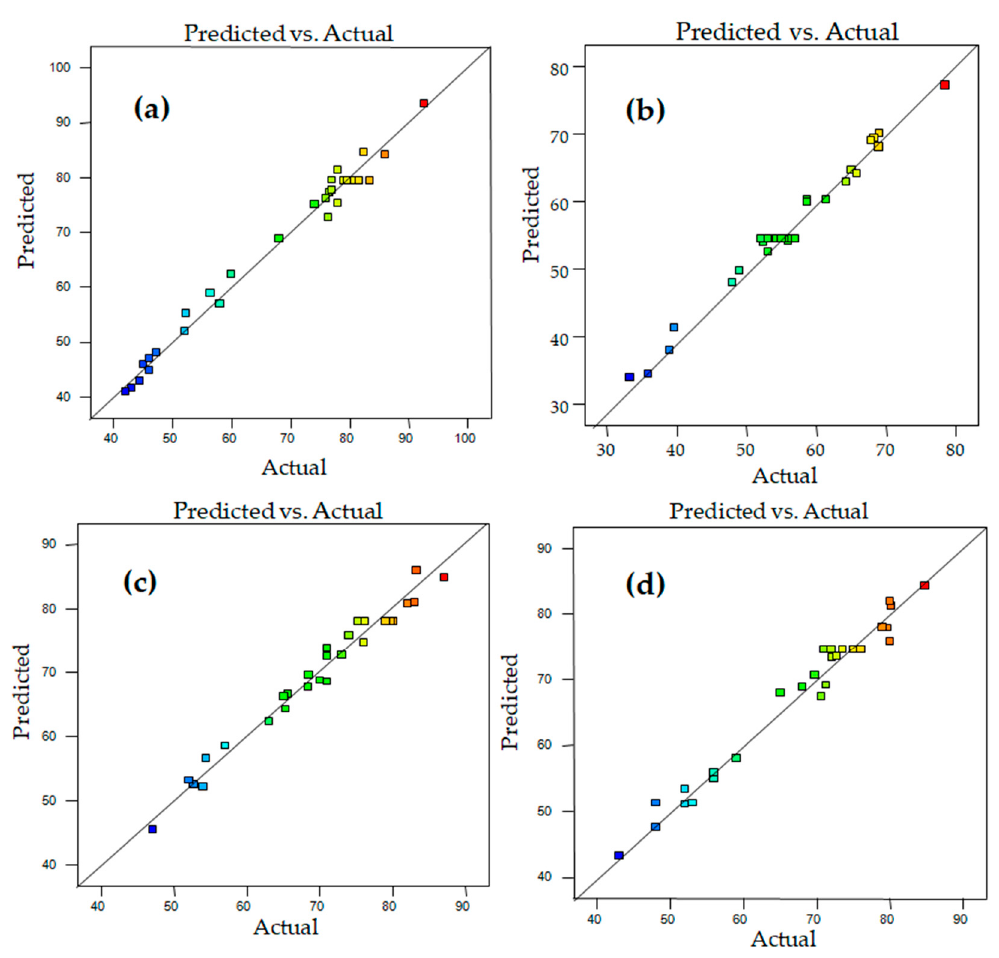
Figure 1. Graphs of predicted vs. actual yield for waste chicken fat oil-based biodiesel by Fe 3 O 4 _PDA_Lipase ( a ), Aspergillus terreus lipase ( b ), Sodium methoxide ( c ) and KOH ( d ).